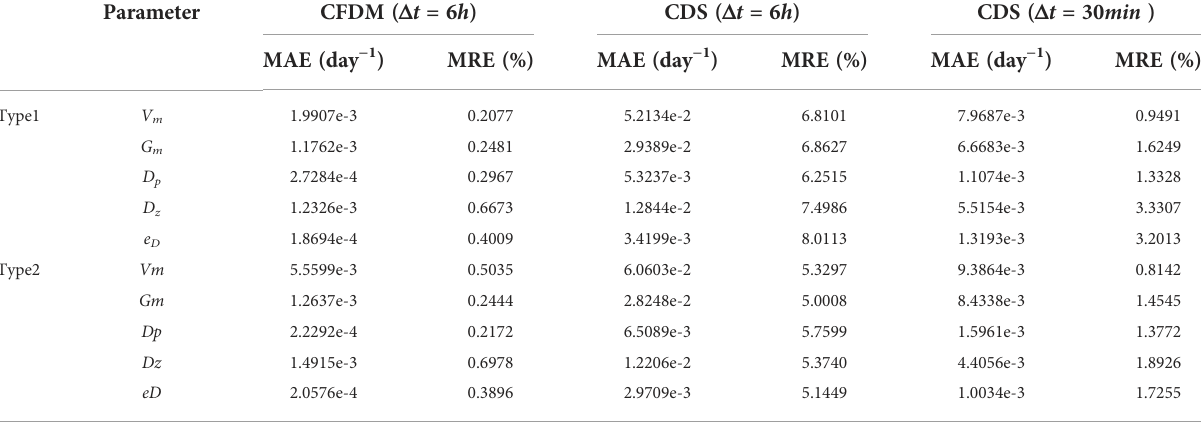
TABLE 4 The errors between the inversion results and the given parameters in the experiment of optimizing parameters